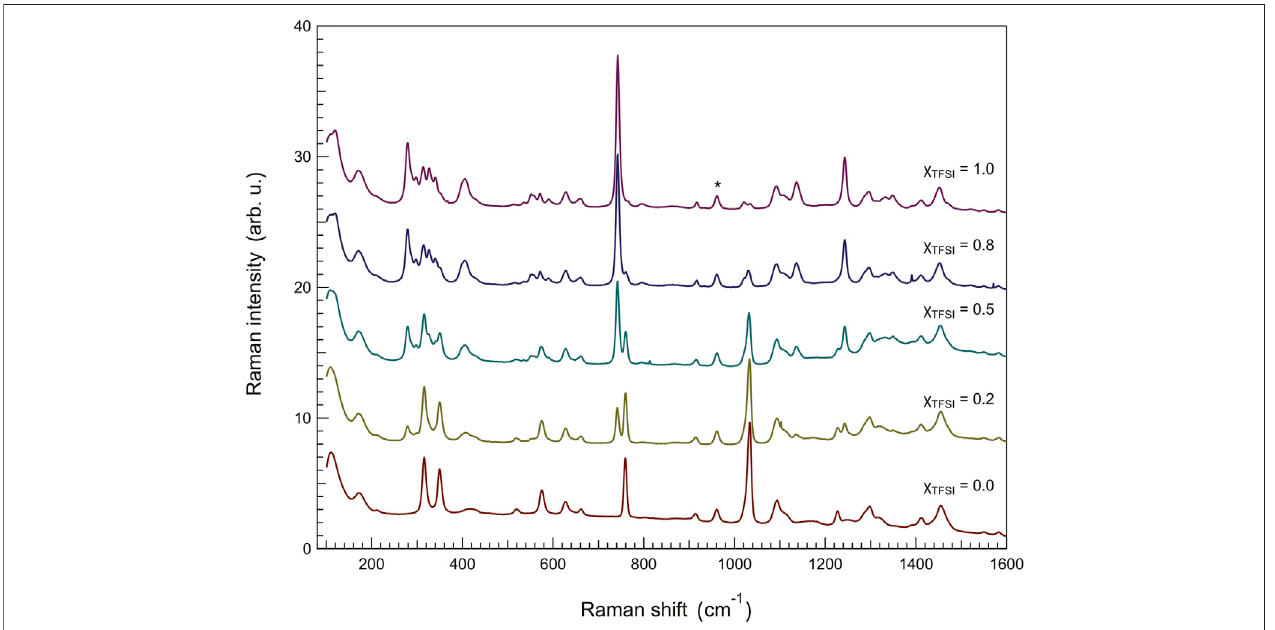
FIGURE 7 | Raman spectra recorded for the binary mixtures, showing the frequency region 80 – 1,600 cm − 1 . The asterisk shows the vibrational mode used for normalization, that is the mode at 961 cm − 1 assigned to the C 6 – C 7 stretching mode in the ethyl chain of the imidazolium cation.